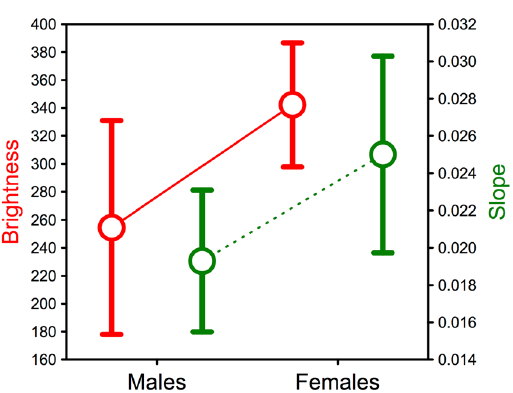
Figure 4. Mean ± 95% confidence interval of brightness (summed reflectance in the range 300–700 nm; left axis, red color) and slope (calculated from the regression of reflectance against wavelength in the range 300– 700 nm; right axis, green color) of chestnut flank feathers of male and female Eurasian nuthatch